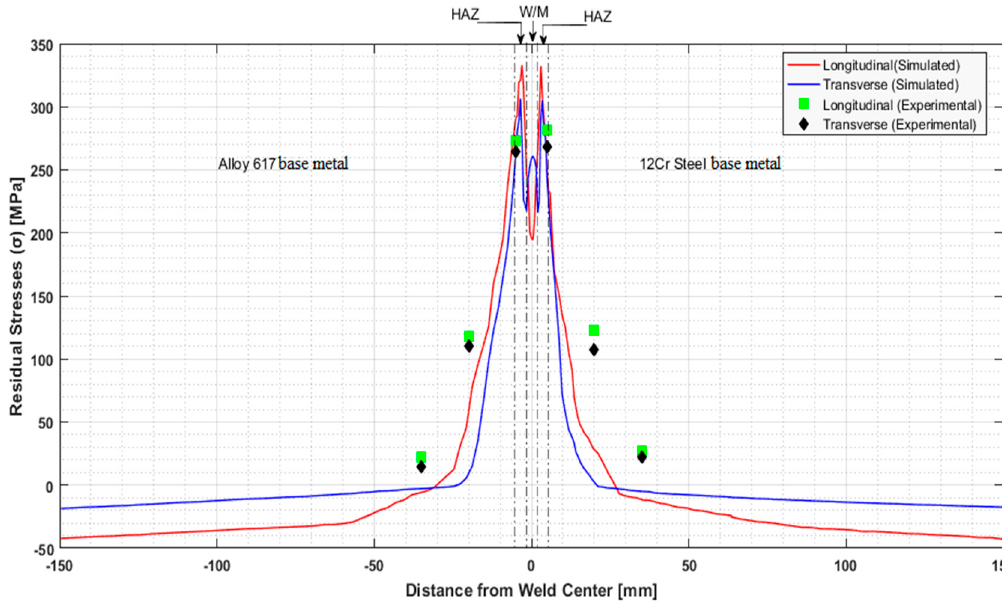
Figure 8. Comparison of FE analysis results with experimental measurements.